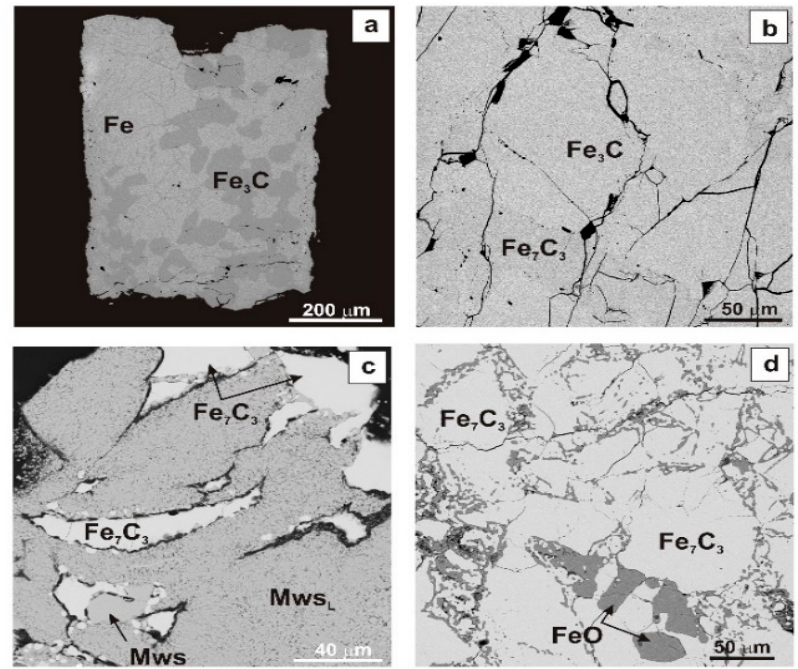
Figure 1. Backscattered electron (BSE) images of quenched samples after 6.3 GPa and 1200 °C runs. ( a ) run 2095_2_2 (Pt capsule); ( b ) run 2095_2_4 (Pt capsule); ( c ) run 688_2_2 (Au capsule); ( d ) run 688_2_3 (Au capsule). Table 2. Chemistry of metal phases according to EDS microanalysis (wt %).